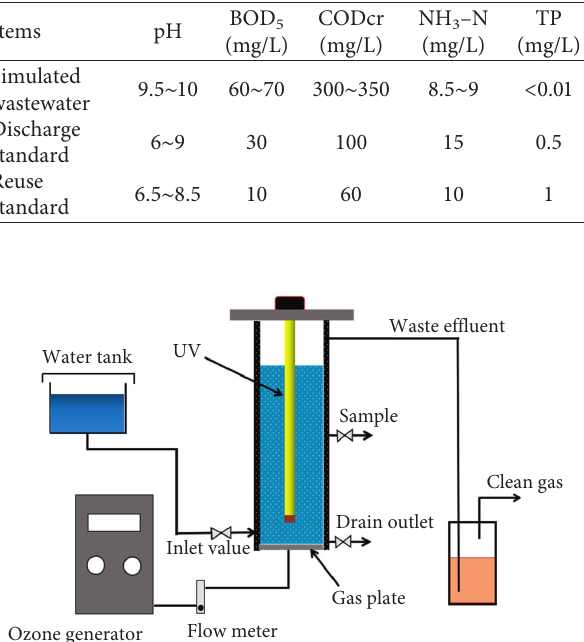
Figure 1: Schematic diagram of experimental devices used in O